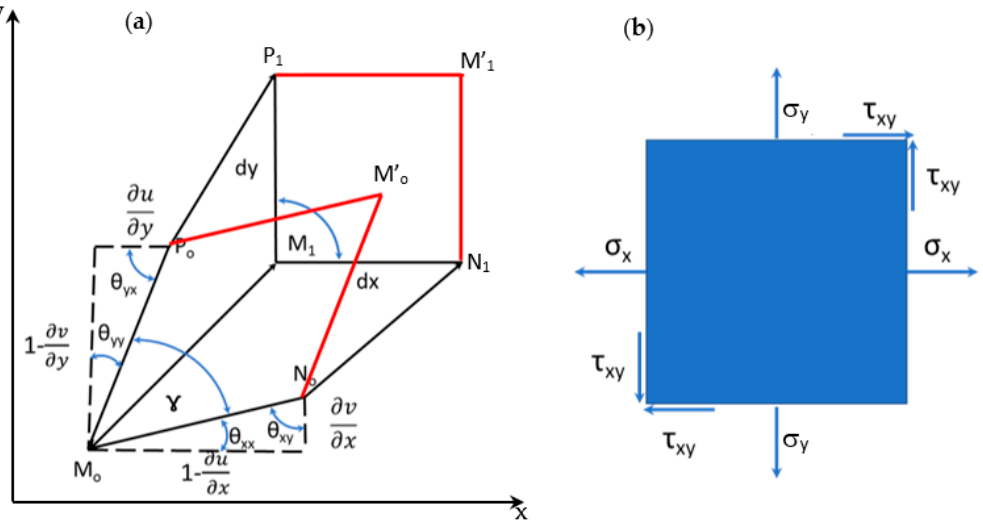
Figure 7. ( a ) The undeformed element M o N o M’ o P o becomes the square M 1 N 1 M’ 1 P 1 in the deformed position; ( b ) Stress components acting on an area element.